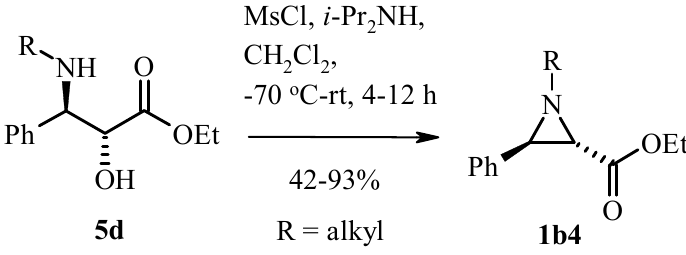
Scheme 12. MsCl/base-promoted cyclization of aminoalcohols 5d .